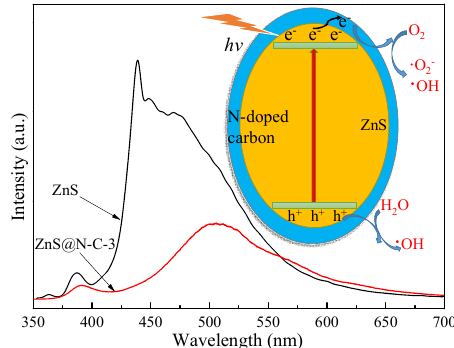
Figure 10. Photoluminescence (PL) spectrum and photocatalytic mechanism of ZnS@N-C-3.